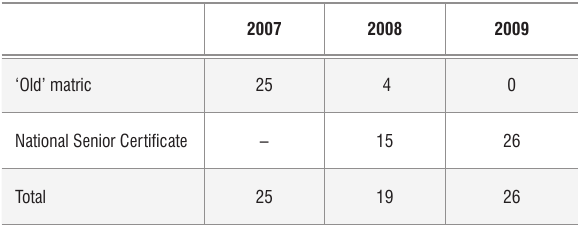
Composition of each cohort of students in the study